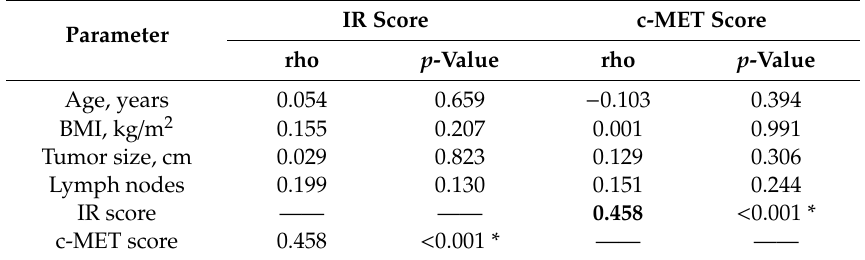
Table 4. Correlation between IR and c-MET expression with demographic and clinicopathologic factors in breast cancer patients ( Continuous variables ) (n =